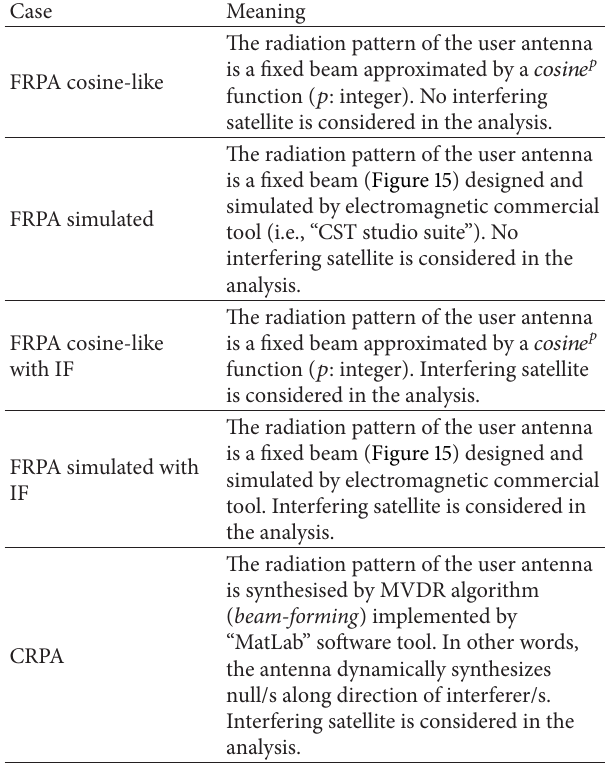
Figure 14: GNSS scenario under study—train path trajectory. Table 5: 7 elements array: cases considered in the navigation realistic